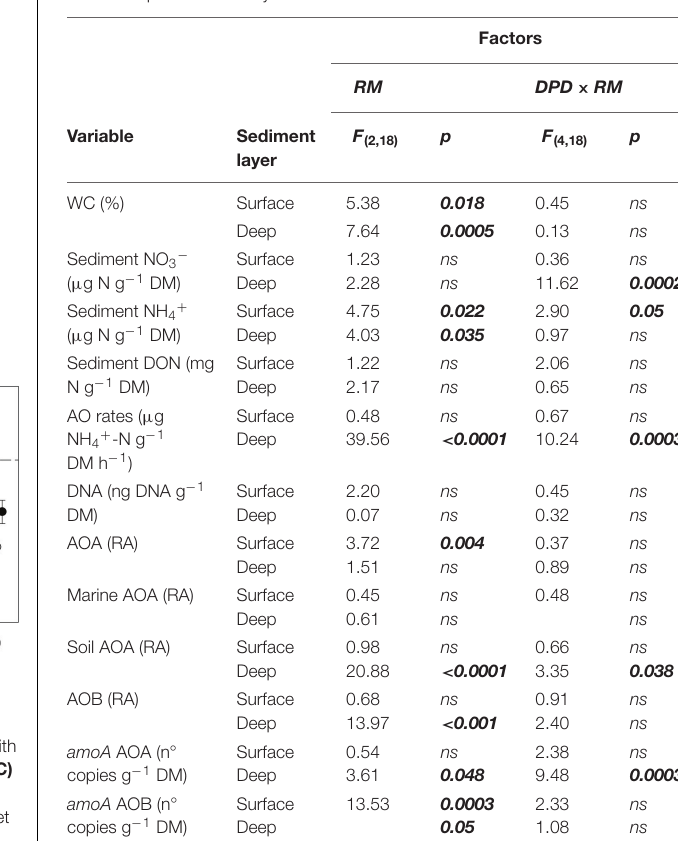
TABLE 1 | Statistical results from the mixed effects models of the variables measured per sediment layer.